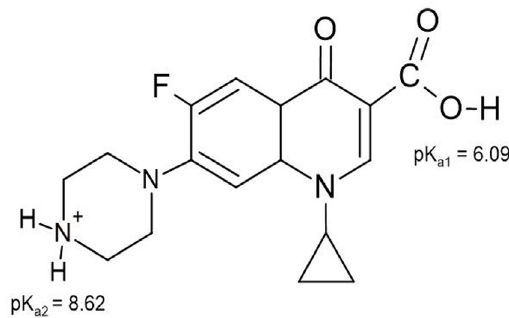
Figure 1. Chemical structure of CIPRO molecule with its ionizable groups and indication of the respective pK